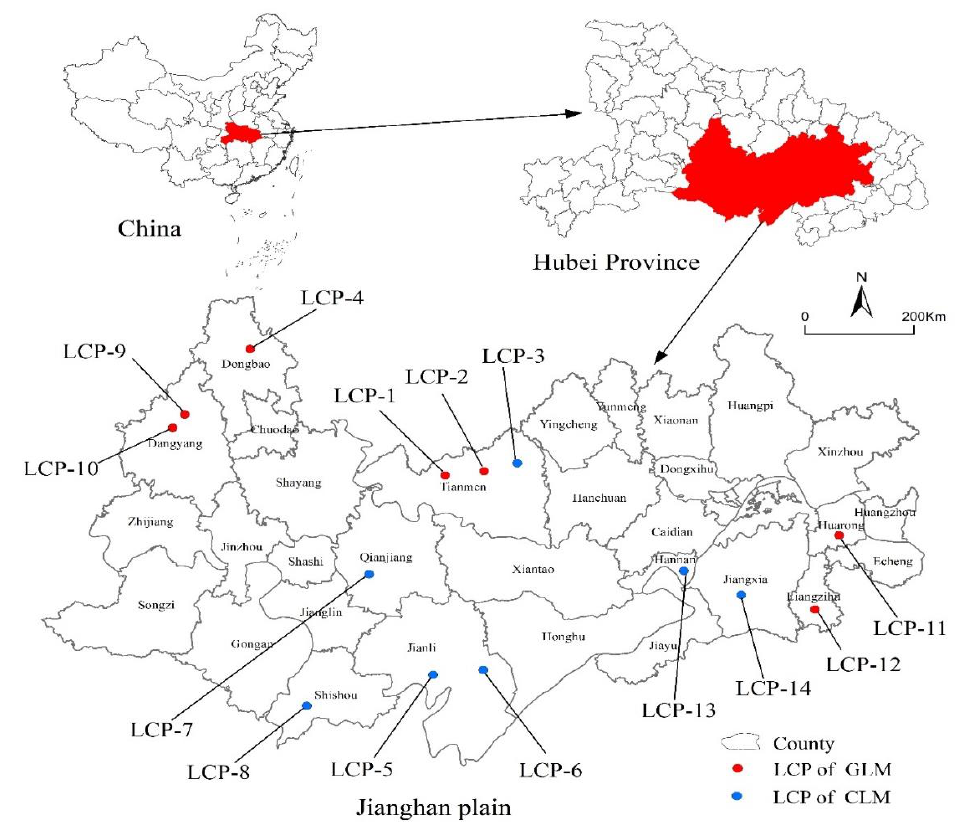
Figure 1. Locations of the study area and distributions of land consolidation projects (LCPs).